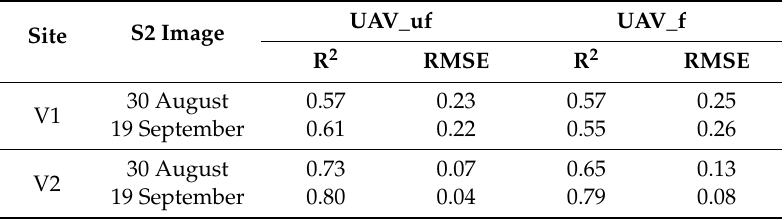
Figure 3. UAV vs. S2 NDVI images 30 August 2015 (red star) and 19 September 2015 (black circle) comparison in V1 (unfiltered (UAV_uf) ( a ) and filtered (UAV_f) ( b )) and V2 (UAV_uf ( c ) and UAV_f ( d )). As might be expected and was reported by Khaliq et al. [61], in both vineyards and images, S2 data show higher correlation with UAV_uf than UAV_f, except for V2 in August (same R 2 value equal to 0.57) (Table 3). The improved e ffi ciency of filtering UAV images is due to soil and shadow pixel removal, which impacts on NDVI, causing lower and higher values, respectively. Table3. ComparisonbetweenUAVunfilteredandfiltered(10September2015)andSentinel-2(30August and 19 September 2015)